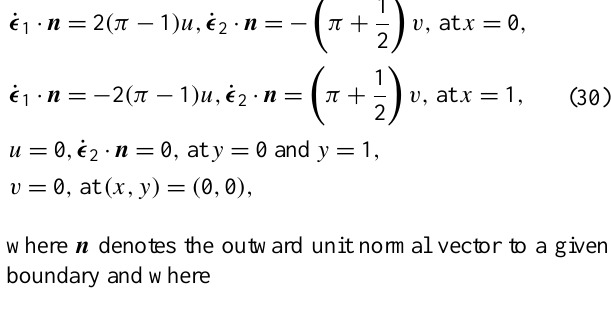
Figure 3. Convergence rates for the x – y MMS test case in the dis- crete l 2 norm Eq.